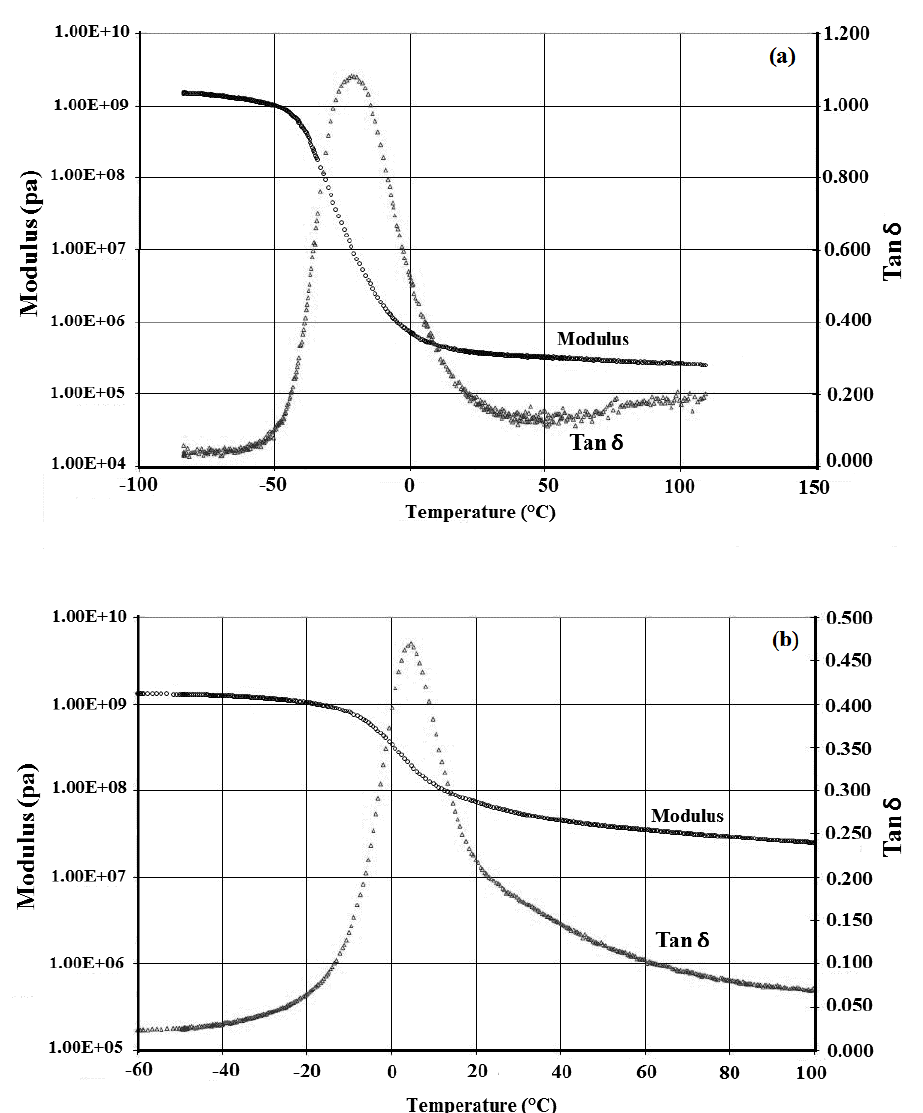
Figure 6. Temperature dependence of storage modulus and loss tangent (tan δ) for ( a ) neat copolymer; and ( b ) synthesized